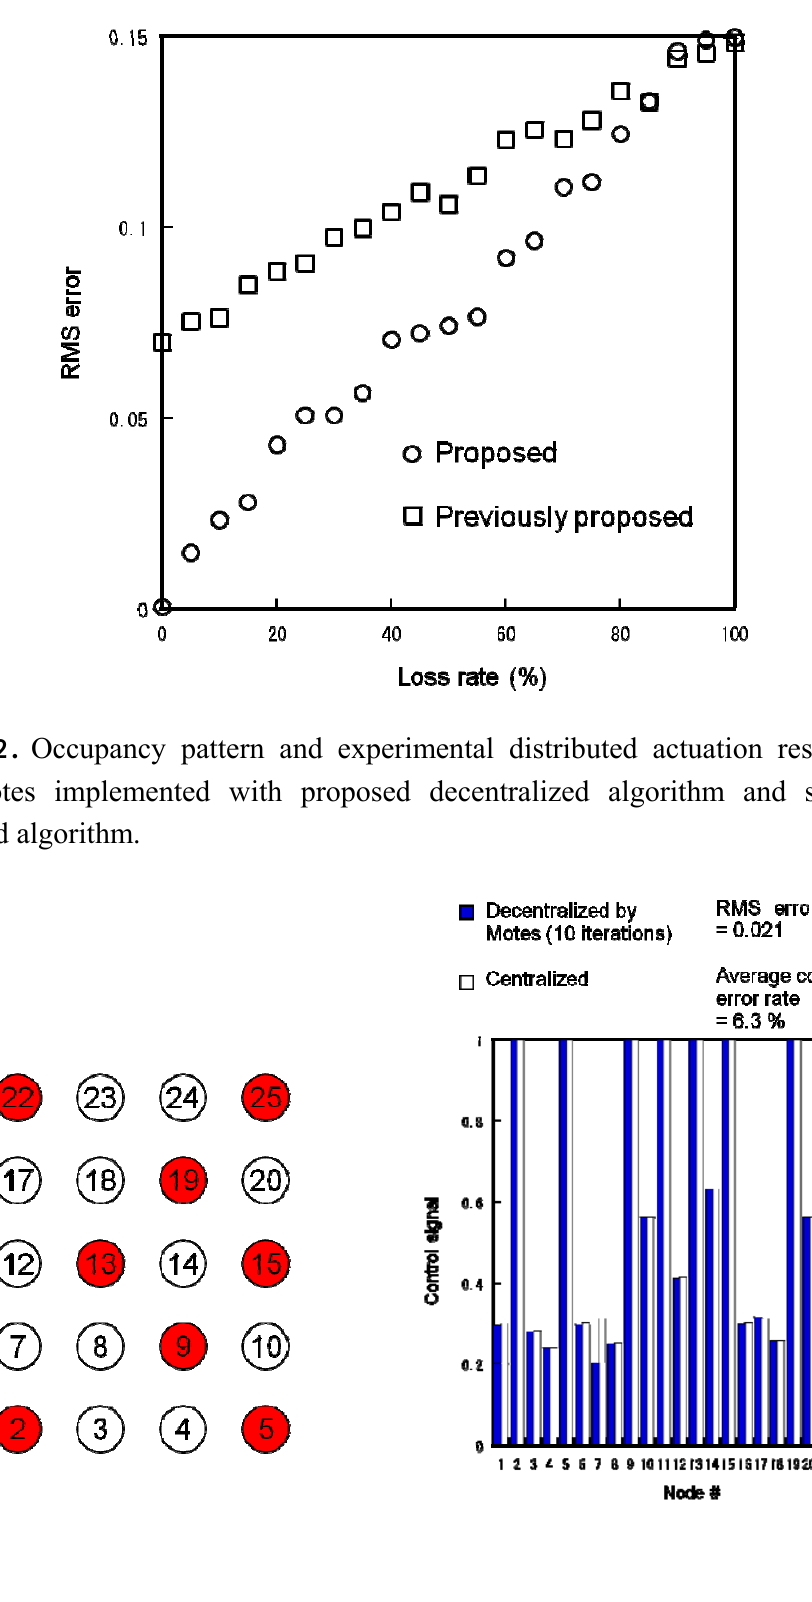
Figure 11. Simulation result of packet loss rate vs. RMS error between centralized and decentralized algorithms (circle: proposed algorithm, square: previously proposed algorithm).